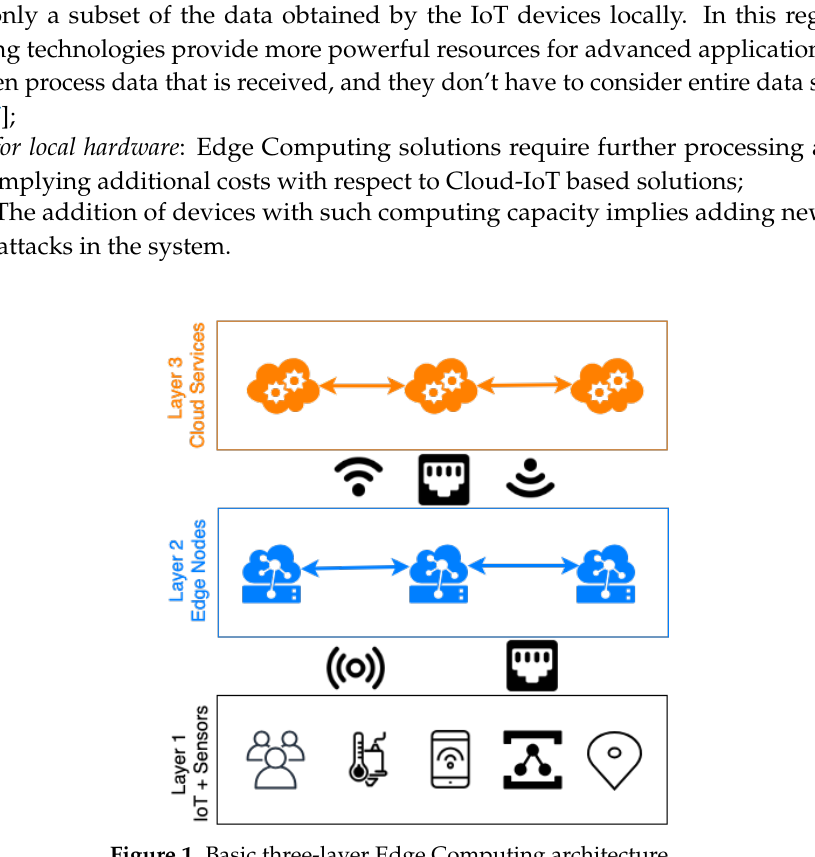
Figure 1. Basic three-layer Edge Computing